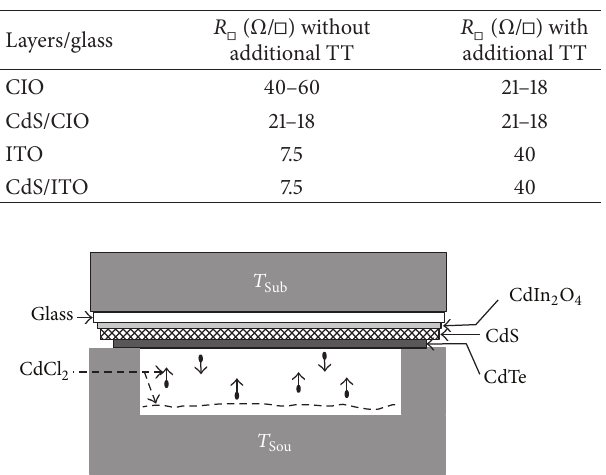
Figure 2: Detail of the 𝑇 and 𝑇 heathers in the CSS system. The Sou Sub figure illustrates the activation process of the CdTe/CdS/CIO/glass heterostructure by means of thermal annealing in CdCl 2 vapor. ≥ 𝑇 is always used. Here, 𝑇 Sub Sou